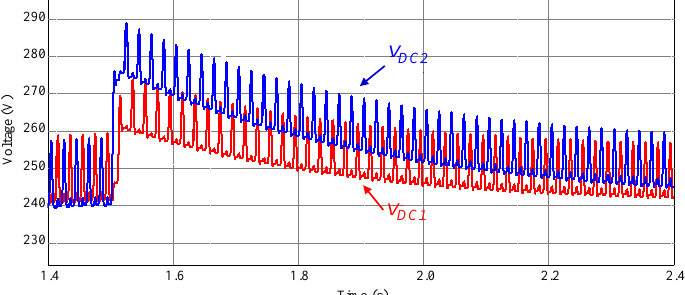
Figure 17. Transient analysis of the SAPF DC-link voltages ( v DC 1 and v DC 2 ) during the disconnection of a non-linear load.